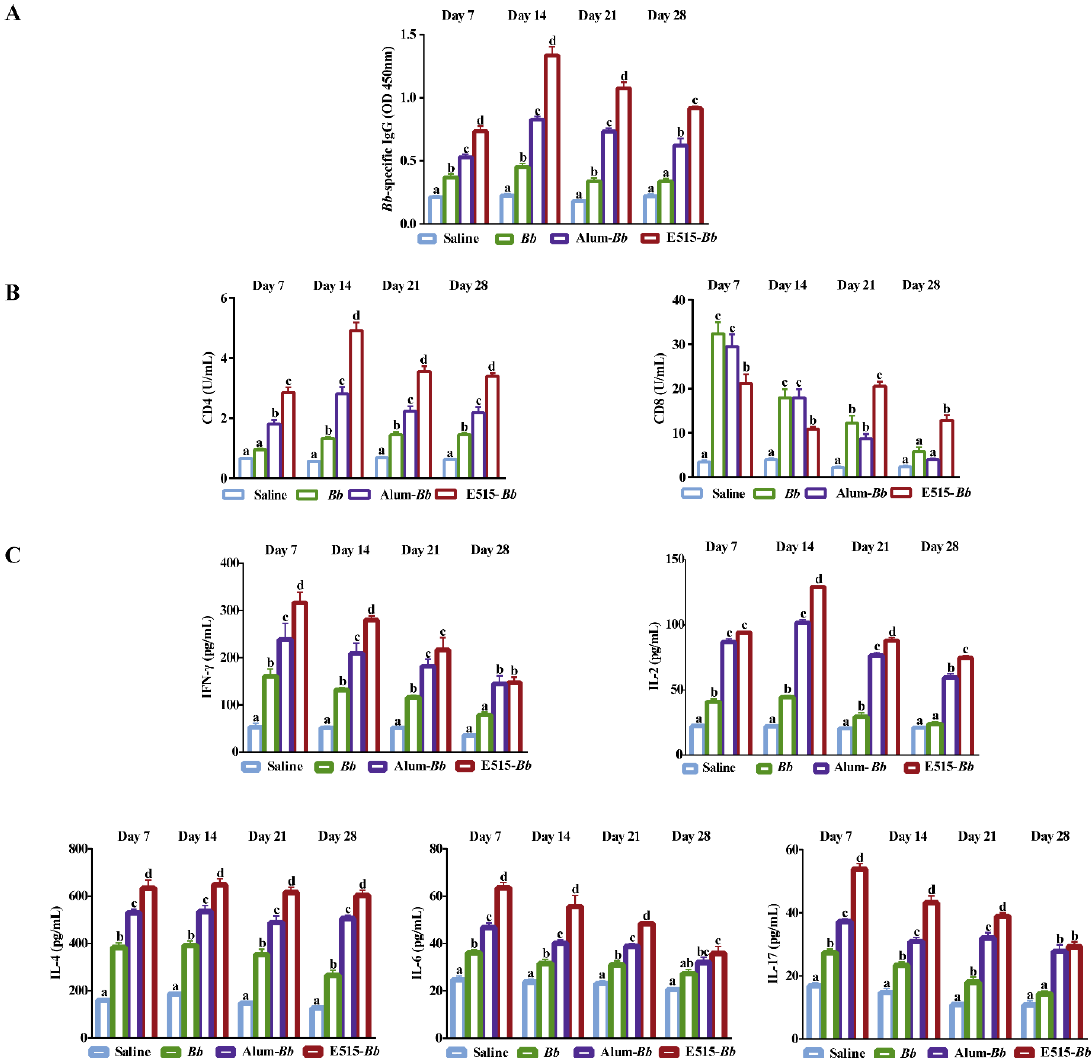
Figure 2. Immune effects of the E515- Bb vaccine. Rabbits ( n = 9/group) were s.c. injected twice at a 2-week interval with 1 mL of saline, inactivated Bb antigen (1.2 × 10 10 CFU/mL), or inactivated Bb antigen adjuvanted with E515 or Alum. Serum samples were collected 7, 14, 21, and 28 days after boosting to measure Bb -specific IgG ( A ), soluble CD4 and CD8 ( B ), Th1 cytokine (IFN- γ and IL-2), Th2 cytokine (IL-4 and IL-6) and Th17 cytokine (IL17) levels ( C ). Data are presented as the mean ± SE. Bars labeled with different lowercase letters (e.g., “a” and “b”) are significantly different ( p < 0.05), and bars labeled with same or common lowercase letters are not statistically different (e.g., “a” and “ab”), ( p ≥ 0.05). 3.3. Assessment of the Role of the E515-Bb Vaccine in Protecting Rabbits from the Bb Challenge To investigate the immunoprotective effect of the E515- Bb vaccine, the survival rate and serum endotoxin and proinflammatory cytokine levels were observed 10 days post- challenge. As presented in Figure 3A, rabbits immunized with the Alum- Bb vaccine or Bb antigen were better protected (62.5% and 44.4% survival) than those in the saline group (11% survival), while the best survival rate was found in the E515- Bb group (100% sur- vival) after challenge. Compared with those in the saline group, the concentrations of en- dotoxin and the proinflammatory cytokines IL-1 β and TNF- α were significantly lower in